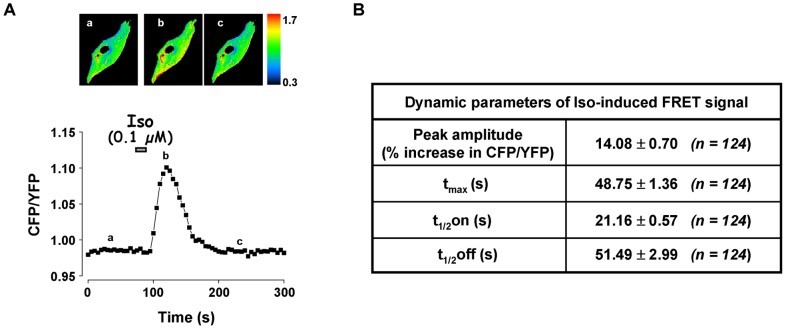
Effect of transient activation of β-AR on cytosolic [cAMP] in RASMCs.Cytosolic cAMP measurements were conducted in cultured RAMSCs cells using the FRET-based cAMP sensor Epac1-camps in response to a short application of isoproterenol (Iso, 0.1 µM, 15 s). A: Representative cAMP signals monitored in one cell. Pseudocolor images reflecting the CFP/YFP ratio were recorded at the times indicated by the letters on the graph. B: Dynamic parameters (peak amplitude, tmax, t1/2on, and t1/2off) of isoproterenol-induced FRET signal as shown in A. Data are mean±SEM of 124 independent cells.